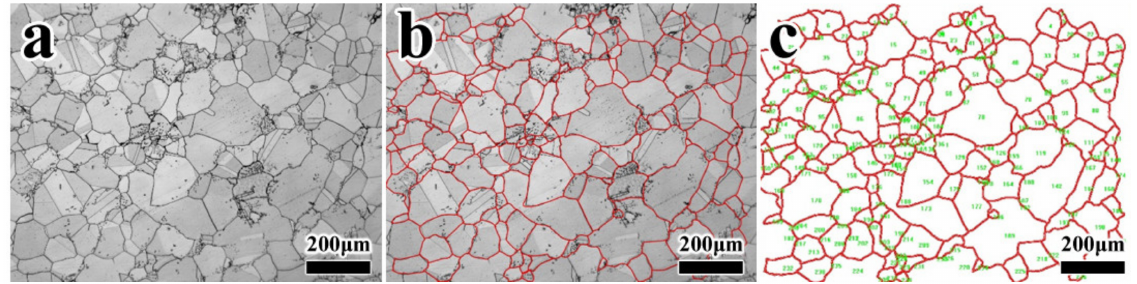
Figure 2. Grain size measurement of GH4975 alloy under isothermally heat treated at the temperature of 1160 ◦ C with a soaking time of 1 h: ( a ) the original image for grain size measurement; ( b ) the digitally processed image; ( c ) grain